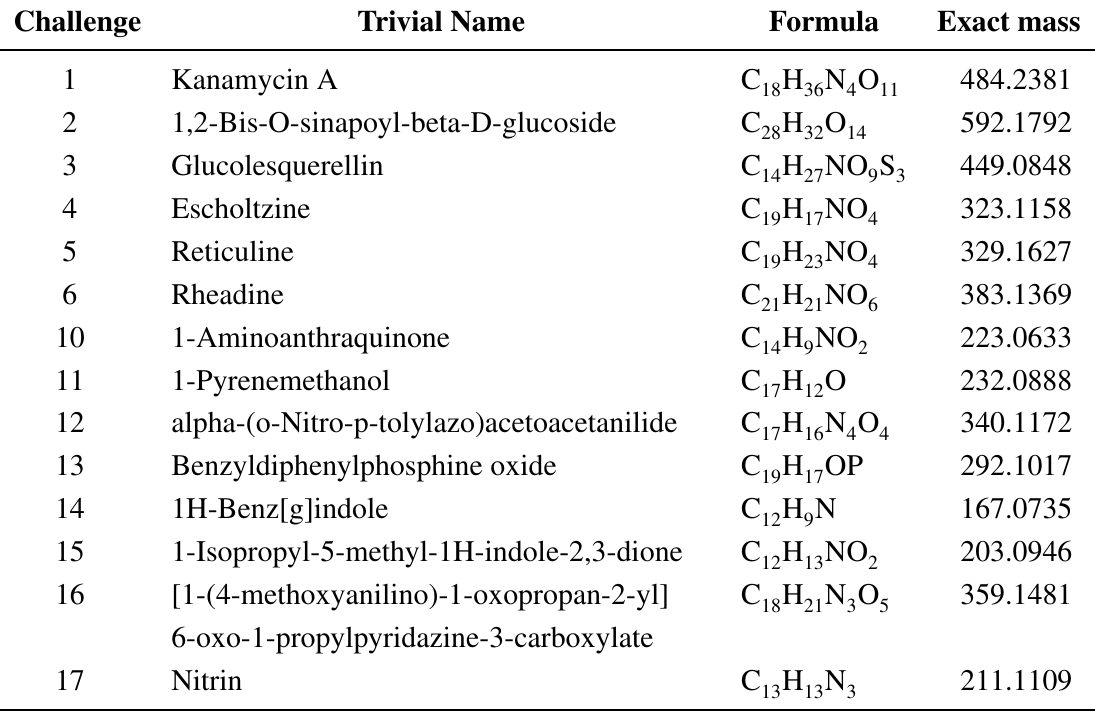
Table 1. Liquid chromatography (LC) Challenges for the C ritical A ssessment of S mall M olecule I dentification (CASMI)